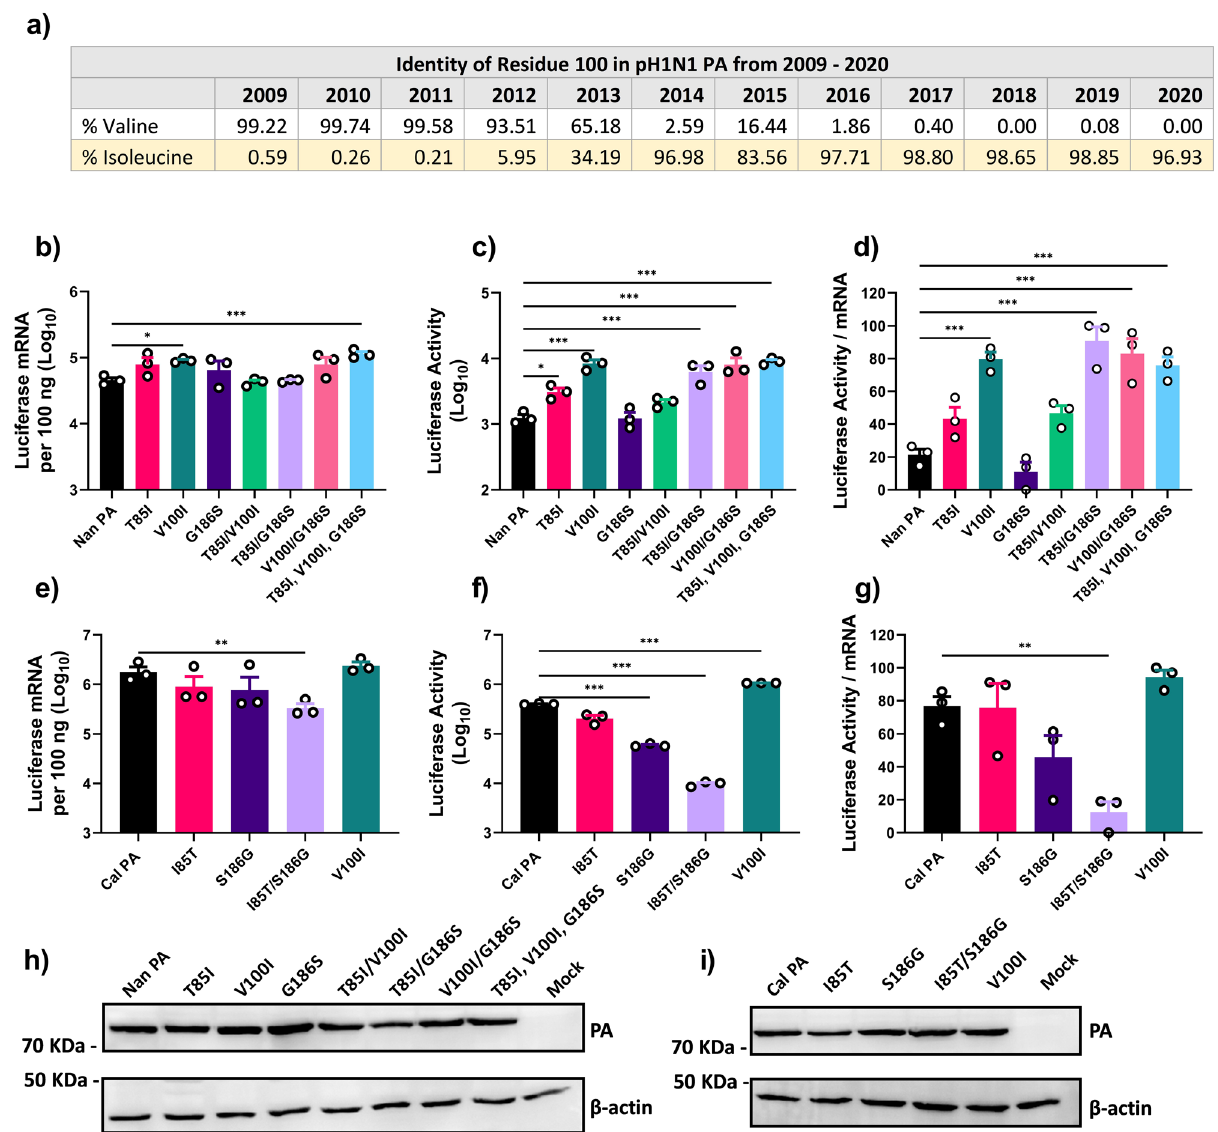
Fig. 3 PA mutations T85I, V100I and G186S increase the translation ef fi ciency. a Percentages of pH1N1 viruses containing valine or isoleucine at residue 100 in PA from 2009 to 2020. Sequences of pH1N1 viruses were downloaded from fl udb.org for comparison. b – d 293 T cells were transfected with expression plasmids for Nan NP, PB1, PB2 and Nan PA with the indicated mutations along with pPolI-NP-luc. e – g 293 T cells were transfected with expression plasmids for Cal NP, PB1, PB2 and Cal PA with the indicated mutations along with pPolI-NP-luc. b , e Luciferase mRNA was quanti fi ed by qRT- PCR. c , f Luciferase activity determined by the Dual-Luciferase Reporter Assay system. d , g Ratio of luciferase activity per mRNA, transformed to a normal distribution. h , i Representative images of immunoblot analysis of PA and β -actin in cell lysates using speci fi c antibodies. Error bars show means plus/ minus the standard deviations ( n = 3 biological replicates). One-way ANOVA followed by Tukey ’ s multiple comparison test (* P < 0.05, ** P < 0.01, *** P <